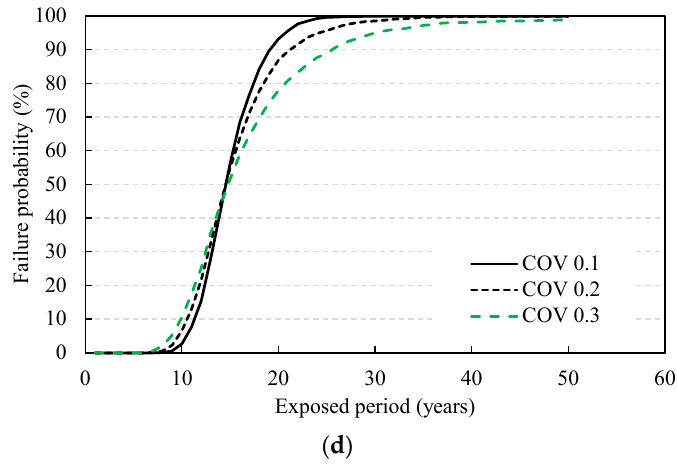
Figure 12. Changes in failure probability with COV variation: ( a ) exterior sulfate ions; ( b ) coating thickness; ( c ) surface roughness; ( d ) diffusion coefficient.